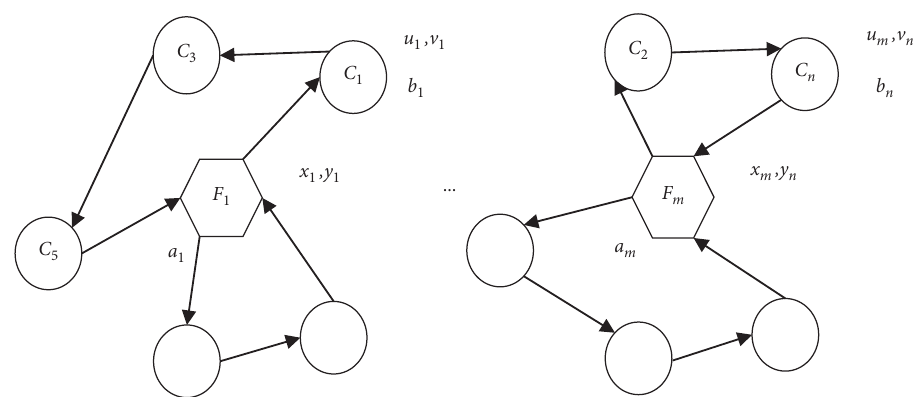
Figure 3: Schematic diagram of vehicle routing